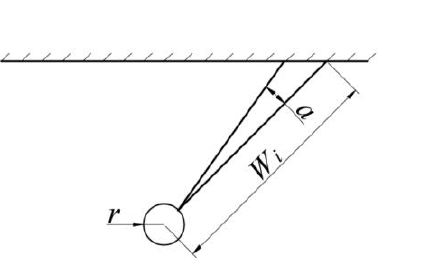
Figure 1. The unit of throwing blast.